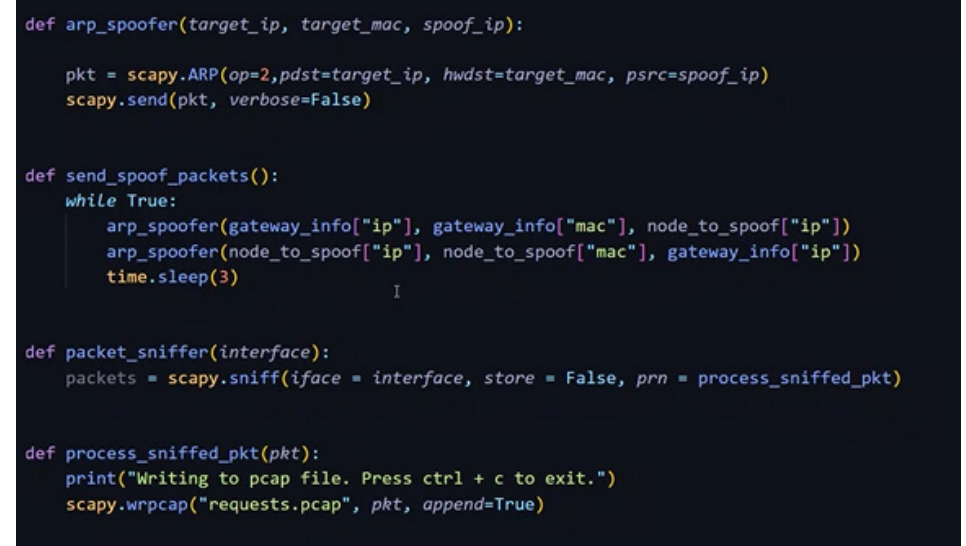
Figure A1. Python snippet for attack packet spoofing function.